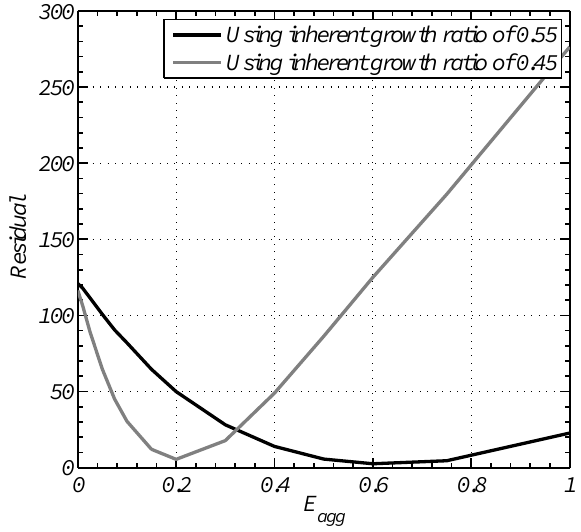
Fig. 13. As in Fig. 12, but for the experiment at − 15 ◦ C. The two curves are the residual plotted for when Γ( − 15)=0 . 55 and Γ( − 15)=0 . 45 . Note that the curve for Γ( − 15)=0 . 55 has a minimum at E agg ∼ =0 . 6 , which is much higher than the previous estimate. Also note that the value of residual at the minimum is less than that for Γ( − 15)=0 . 45 , so this solution better matches the data.